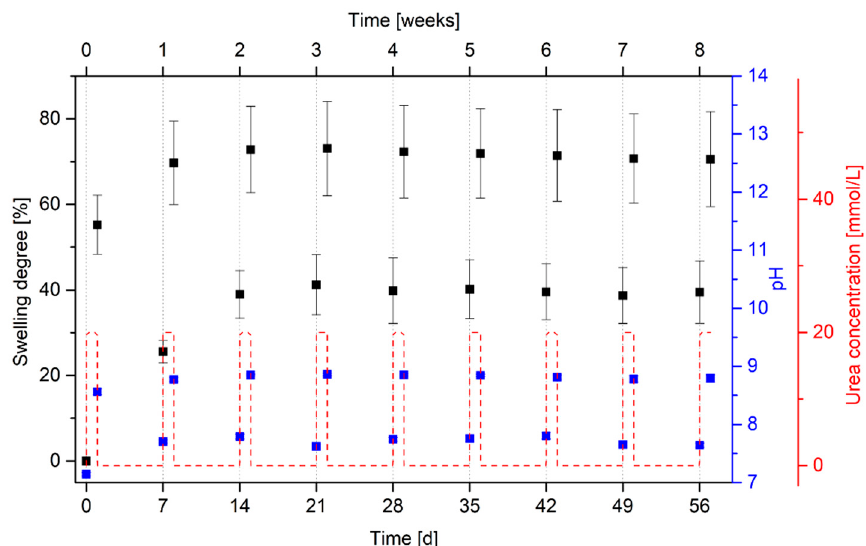
Figure 5. Long-term stability of urease-functionalized poly(AAc- co -DMAEMA) hydrogels during cycling between two alternating urea concentrations (20 mmol/L and 0 mmol/L) in PBS buffer. The resulting pH change in the surrounding solutions due to the enzymatic reaction was detected at the same time. Black squares describe the swelling degree of the gels, blue squares characterize the pH value of the surrounding solutions and the red line represents the urea concentration during this swelling experiment.